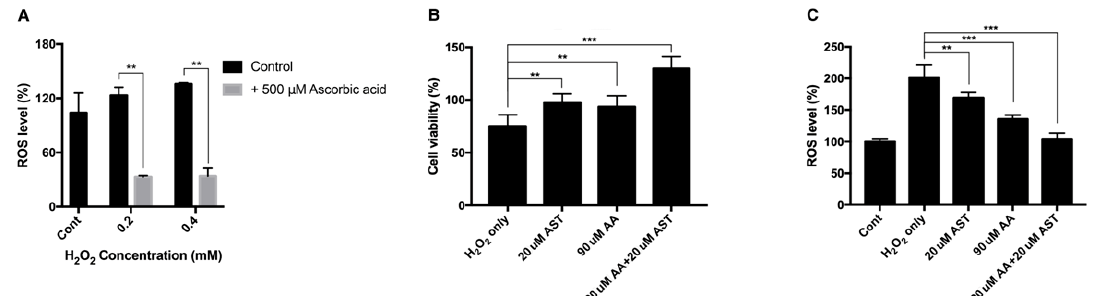
Figure 7. Intracellular ROS level and cell viability of ARPE-19 after H 2 O 2 exposure with ascorbic acid and the mixture of ascorbic acid and astaxanthin. Ascorbic acid at 500 µ M significantly reduced the intracellular ROS level under sublethal and lethal dose of H 2 O 2 (0.2–0.4 mM) compared to the control group without ascorbic acid treatment ( A ). The e ff ect of 20 µ M astaxanthin, 90 µ M ascorbic acid, and the mixture of the two compounds on the cell viability of ARPE-19 under H 2 O 2 -induced oxidative stress was examined by MTT assay. Cell viability was significantly increased when the cells were pretreated with 20 µ M astaxanthin, 90 µ M ascorbic acid, and the mixture of the two compounds for 6 h and with 0.2 mM H 2 O 2 for 24 h, compared to H 2 O 2 only ( B ). ROS level was significantly decreased when the cells were pretreated with 20 µ M astaxanthin, 90 µ M ascorbic acid, and the mixture of the two compounds for 6 h and with 0.2 mM H 2 O 2 for 24 h, compared to H 2 O 2 only. Asterisks indicate a significant di ff erence between increment in cell viability and reduction in intracellular ROS level compared to control cells only with H 2 O 2 exposure without antioxidant treatment ( C ). (** p < 0.01, *** p < 0.001). AST, astaxanthin; AA, ascorbic acid; ROS, reactive oxygen species; MTT, 3-(4,5-dimethylthiazol-2-yl)-2,5-diphenyltetrazolium bromide.